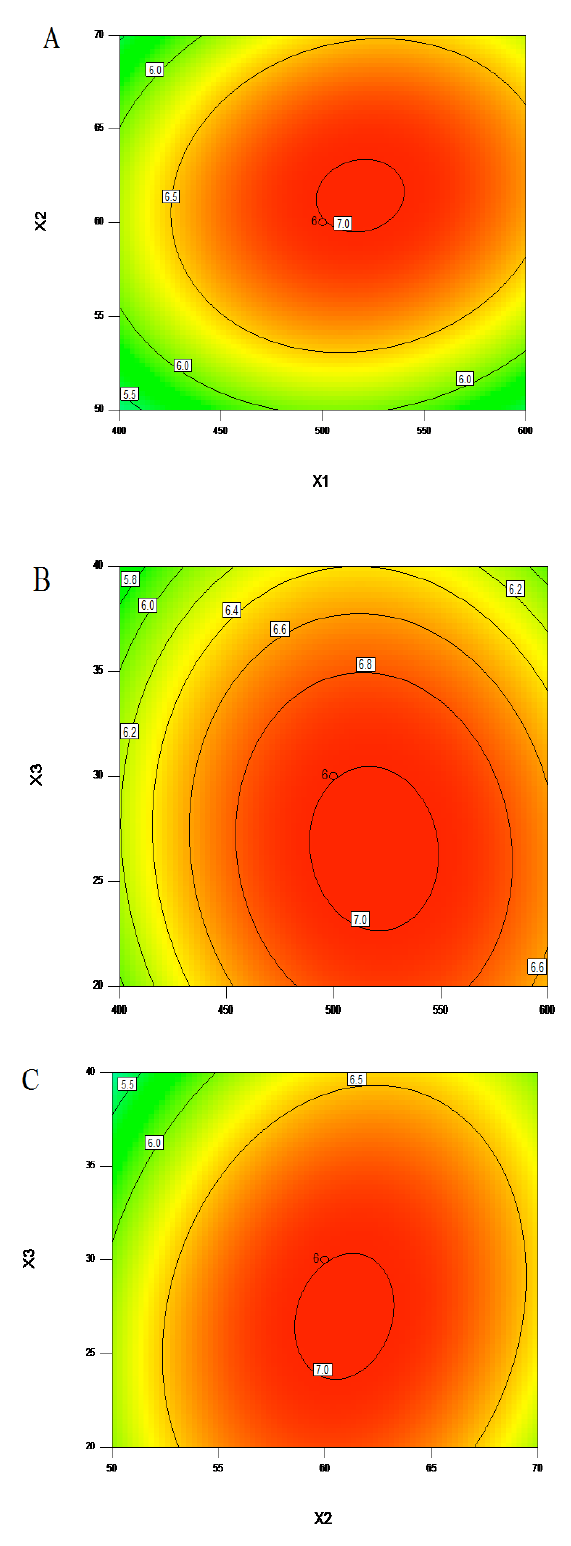
Fig. 2: Contour plots for the effect of independent variables on polyphenols extraction yield. (A) Contour plot graph showing interaction between ultrasonic power (X 1 /W) and ethanol concentration (X 2 /%); (B) Contour plot graph showing interaction between ultrasonic power (X 1 /W) and solvent-to-material ratio (X 3 /mL/g); (C) Contour plot graph showing interaction between ethanol concentration (X 2 /%) and solvent- to-material ratio (X 3 /m/g).